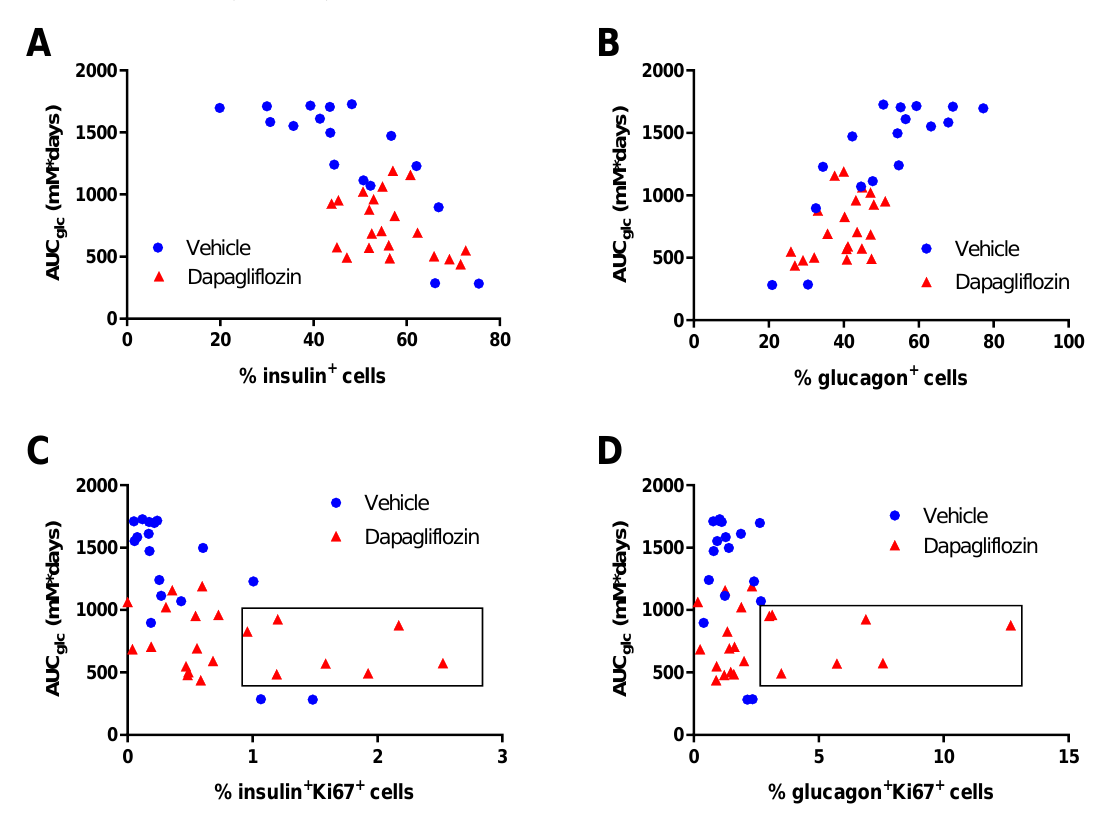
Figure 4. Human islet composition and proliferation in relation to glycemia. Individual analysis of plasma glucose over the 8-week study and the number of insulin and glucagon-positive cells at the end of the study. The AUC for glucose during the study was calculated from the data in Figure 1C and plotted against the percentage of ( A ) insulin-positive and ( B ) glucagon-positive cells or percentage of proliferating ( C ) beta cells (insulin + Ki67 + ) and ( D ) alpha cells (glucagon + Ki67 + ) in the human islet grafts. The boxes in ( C ) and ( D ) indicate the group of mice with high alpha and beta cell proliferation rates (>2.5% and >1%, respectively). Number of samples were n = 21 (dapagliflozin, red symbols) and n = 17 (vehicle, blue symbols).